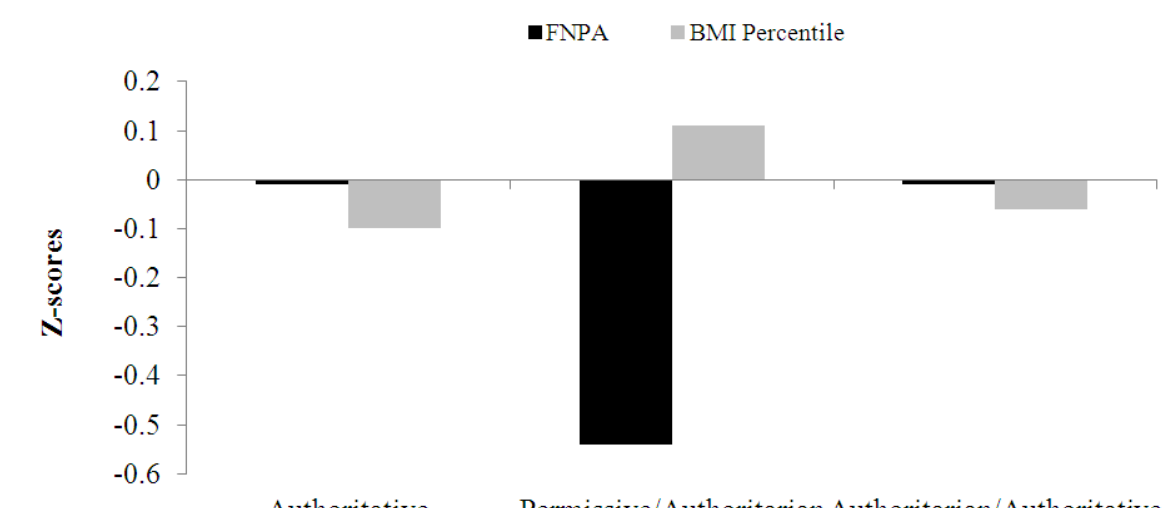
Figure 3. Clusters average z-scores on FNPA and BMI